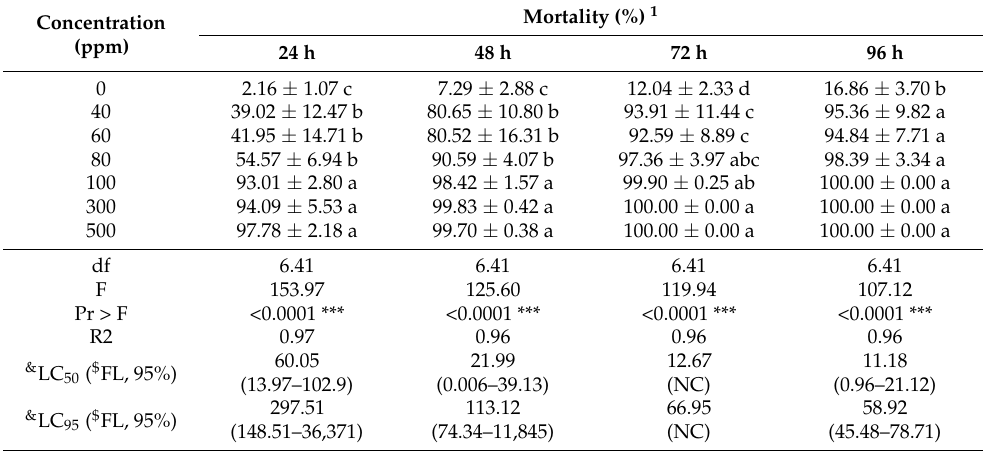
Table 3. Mortality ( ± SD) of tomato psyllid Bactericera cockerelli , at different concentrations of TiO 2 NPs on tomato leaves in the